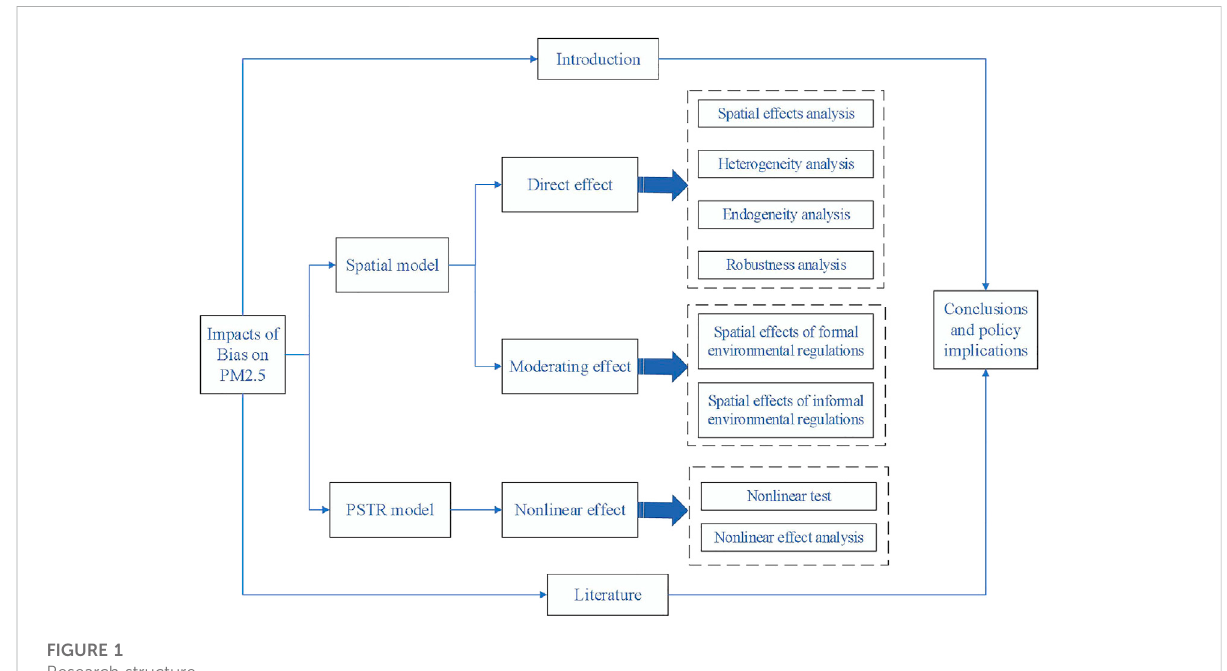
FIGURE 1 Research